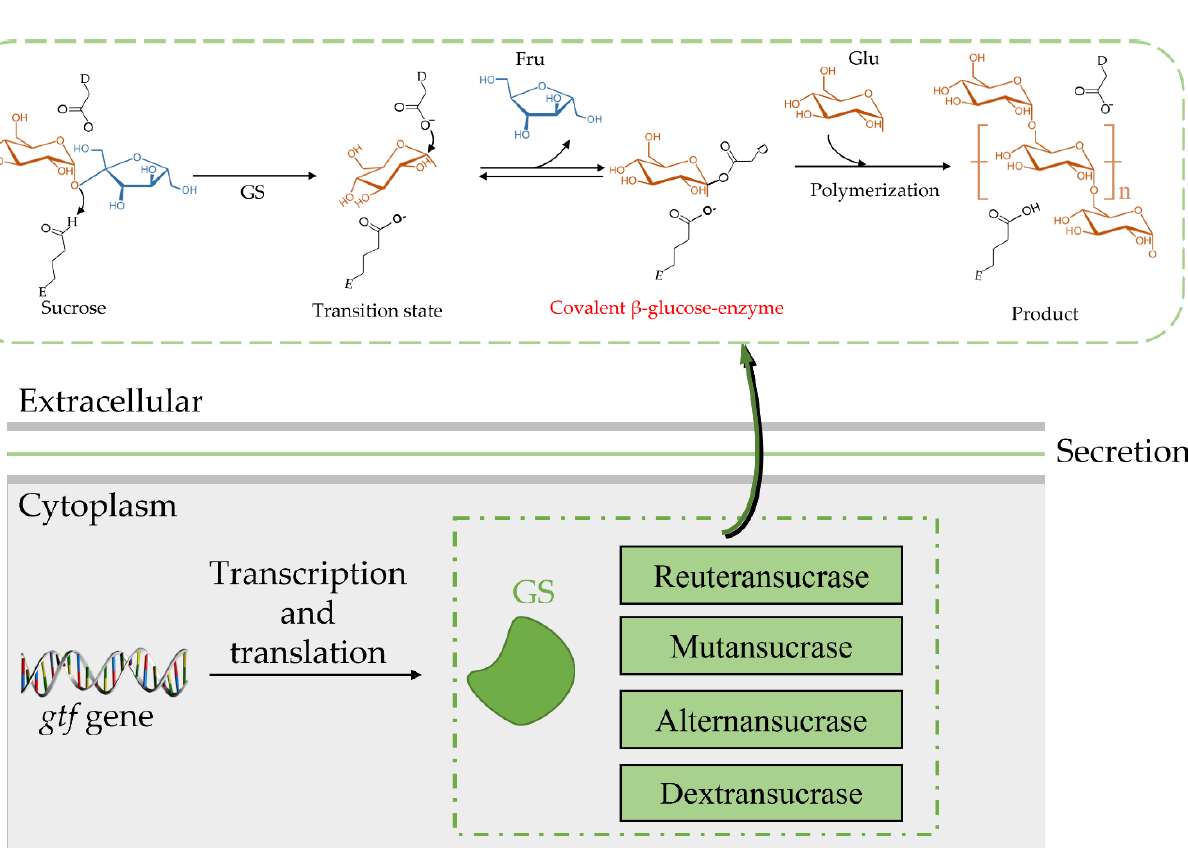
Figure 2. General reaction mechanism for GH70 glucansucrases; D is the nucleophilic asparte resi- due; E is the general acid/base residue [27]. E is the general acid/base residue